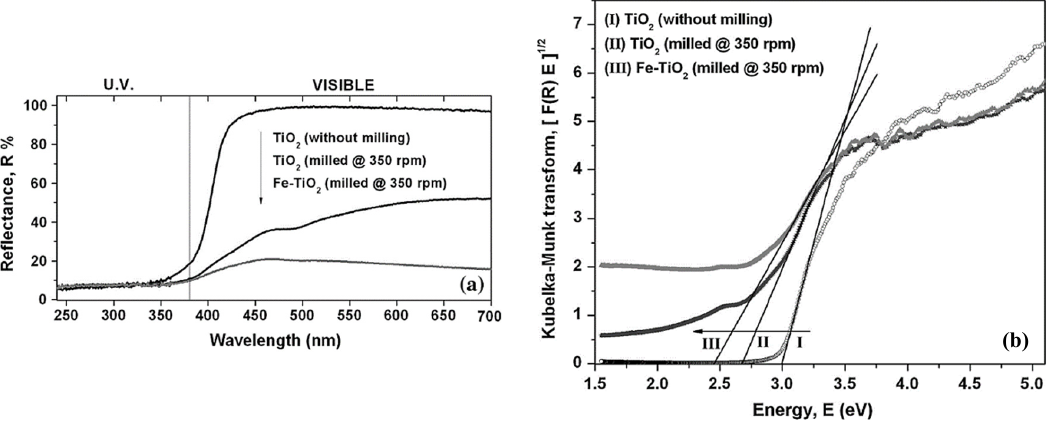
Figure 2. Diffuse reflectance spectroscopy of TiO 2 nanoparticles ( a ) and calculation of the TiO 2 energy band gap by the Kubelka–Munk theory ( b ). Reprinted with permission from [42]. Copyright 2014 Springer